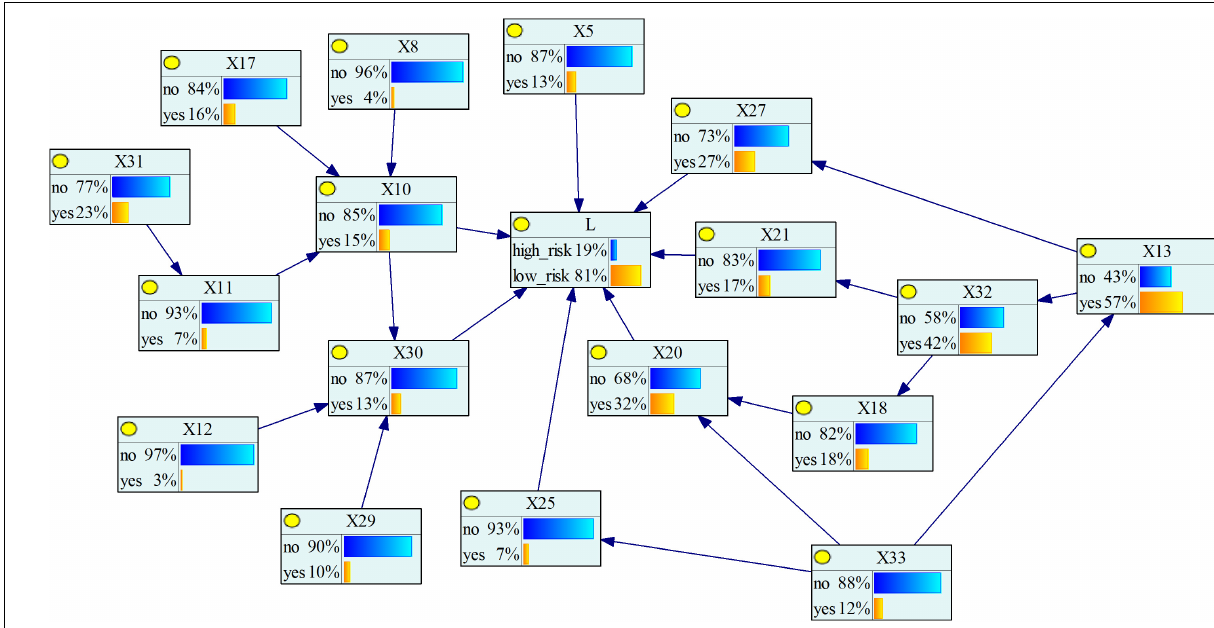
FIGURE 6 | Bayesian network parameter learning results.